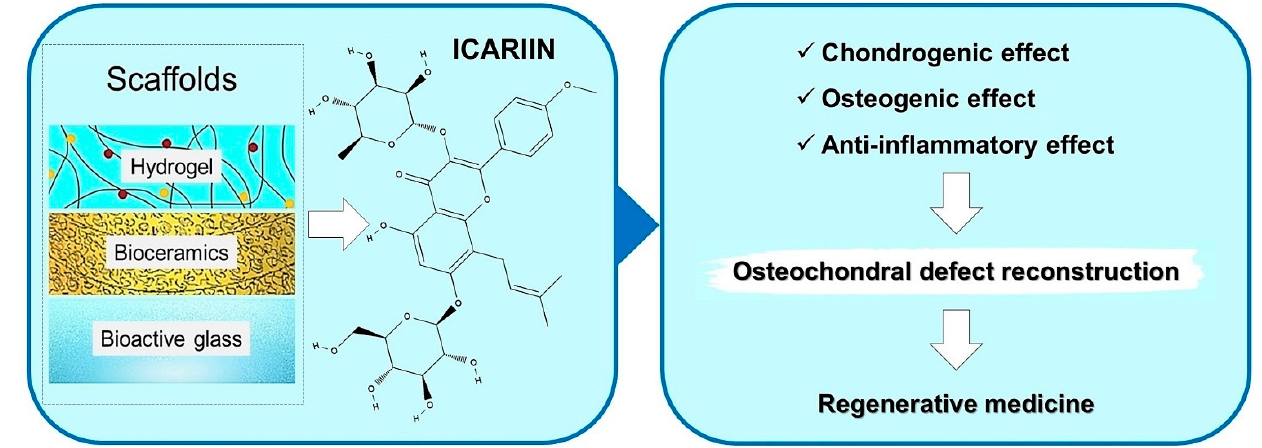
Figure 4. Types of functional composite biomaterials conditioned as hydrogel, containing bioceramics or bioglasses for controlled delivery of icariin are a promising therapeutic approach in osteochondral defect reconstruction.